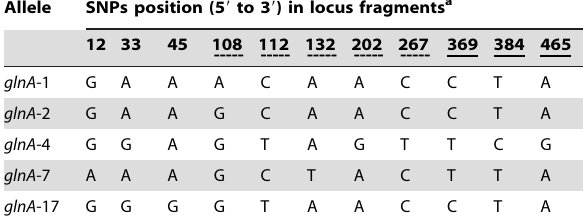
Table 2. SNPs in glnA locus fragments.